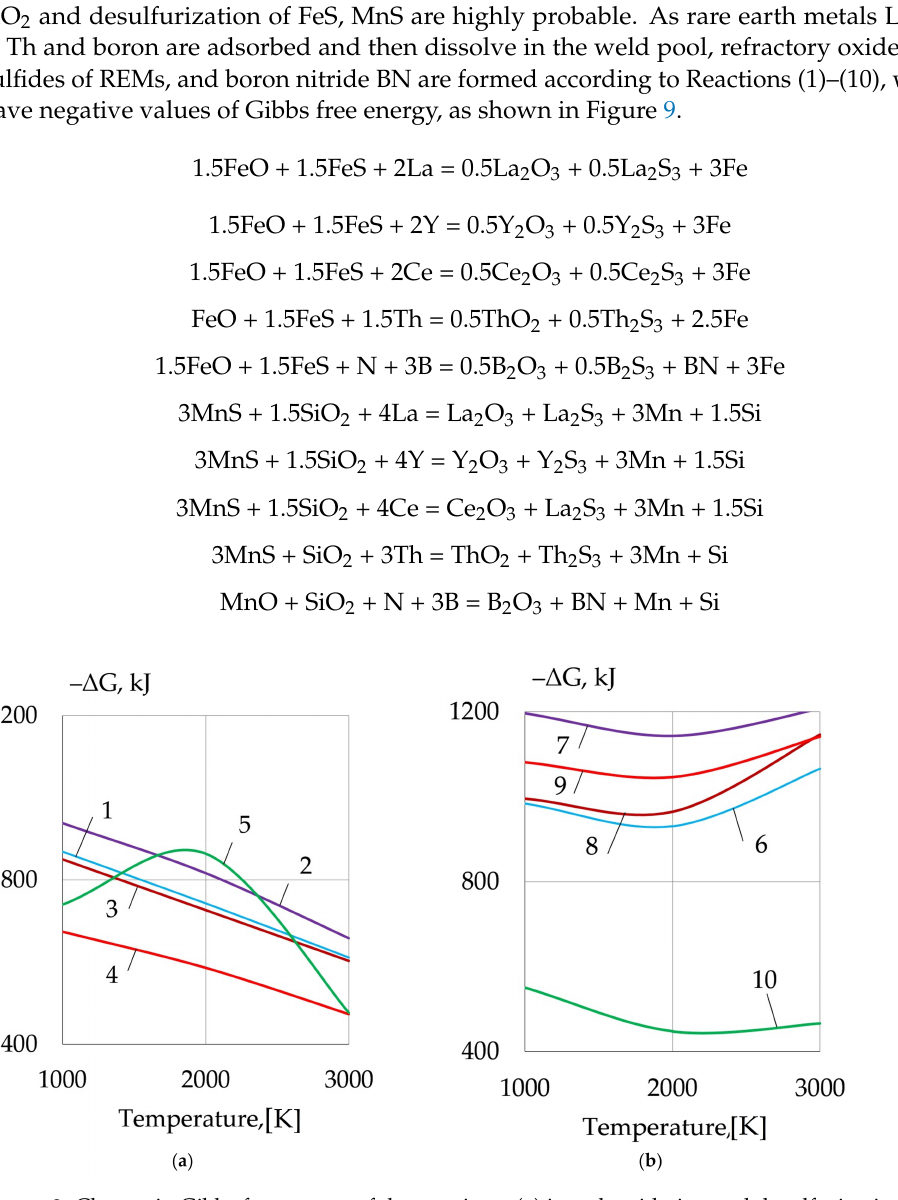
Figure 9. Change in Gibbs free energy of the reactions: ( a ) iron deoxidation and desulfurization (1–5); ( b ) silicon deoxidation and manganese desulfurization